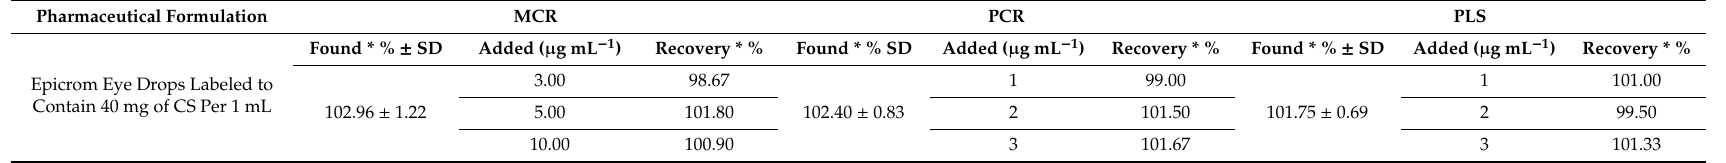
Table 6. Determination of CS in its pharmaceutical formulation by the proposed methods and application of standard addition